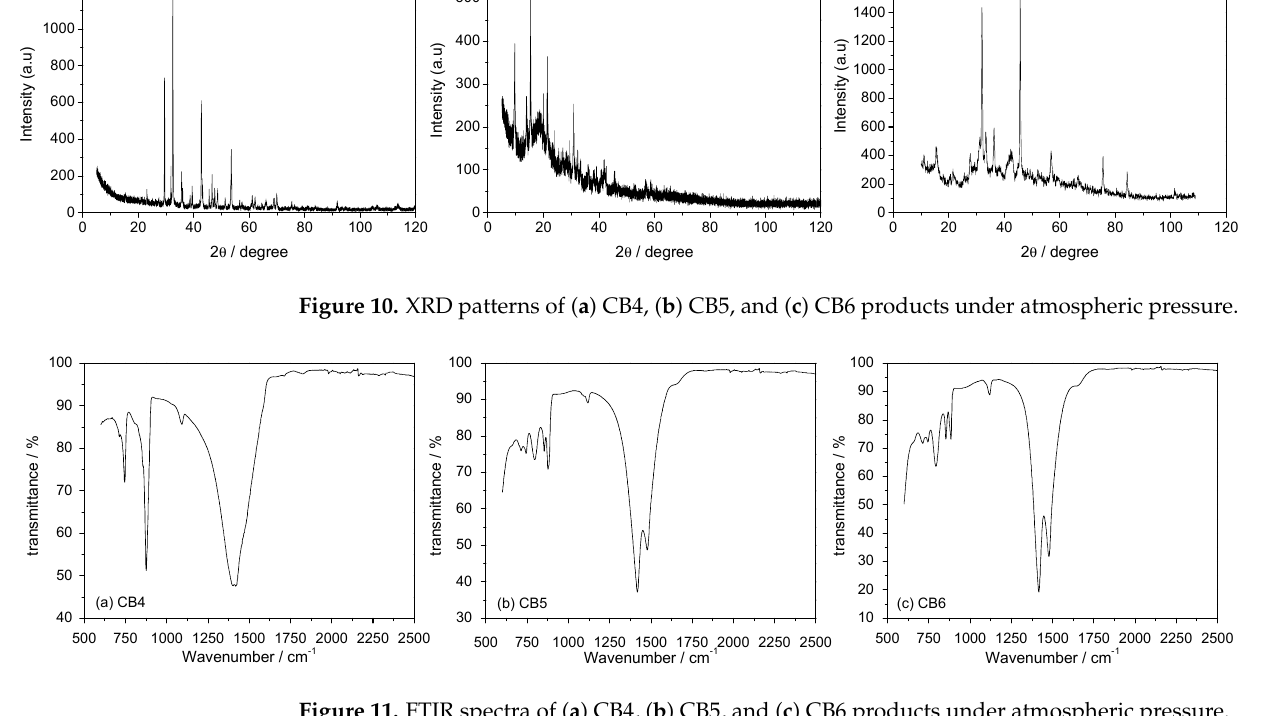
Figure 11. FTIR spectra of ( a ) CB4, ( b ) CB5, and ( c ) CB6 products under atmospheric pressure.